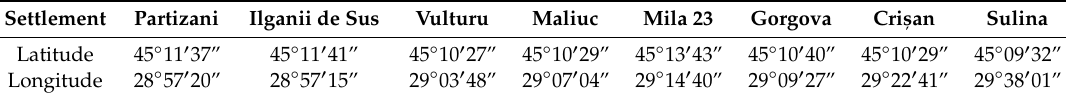
Figure 9. Rupture scenarios (breaches) in the dykes of the settlements Mila 23, Gorgova, Crișan, and Sulina: the upper line of subfigures show the location of the breaches on ortophotomap, second line of subfigures shows the breaches in the dyke on DTM representation. Table 2. The locations of the breaches considered in the dyke.